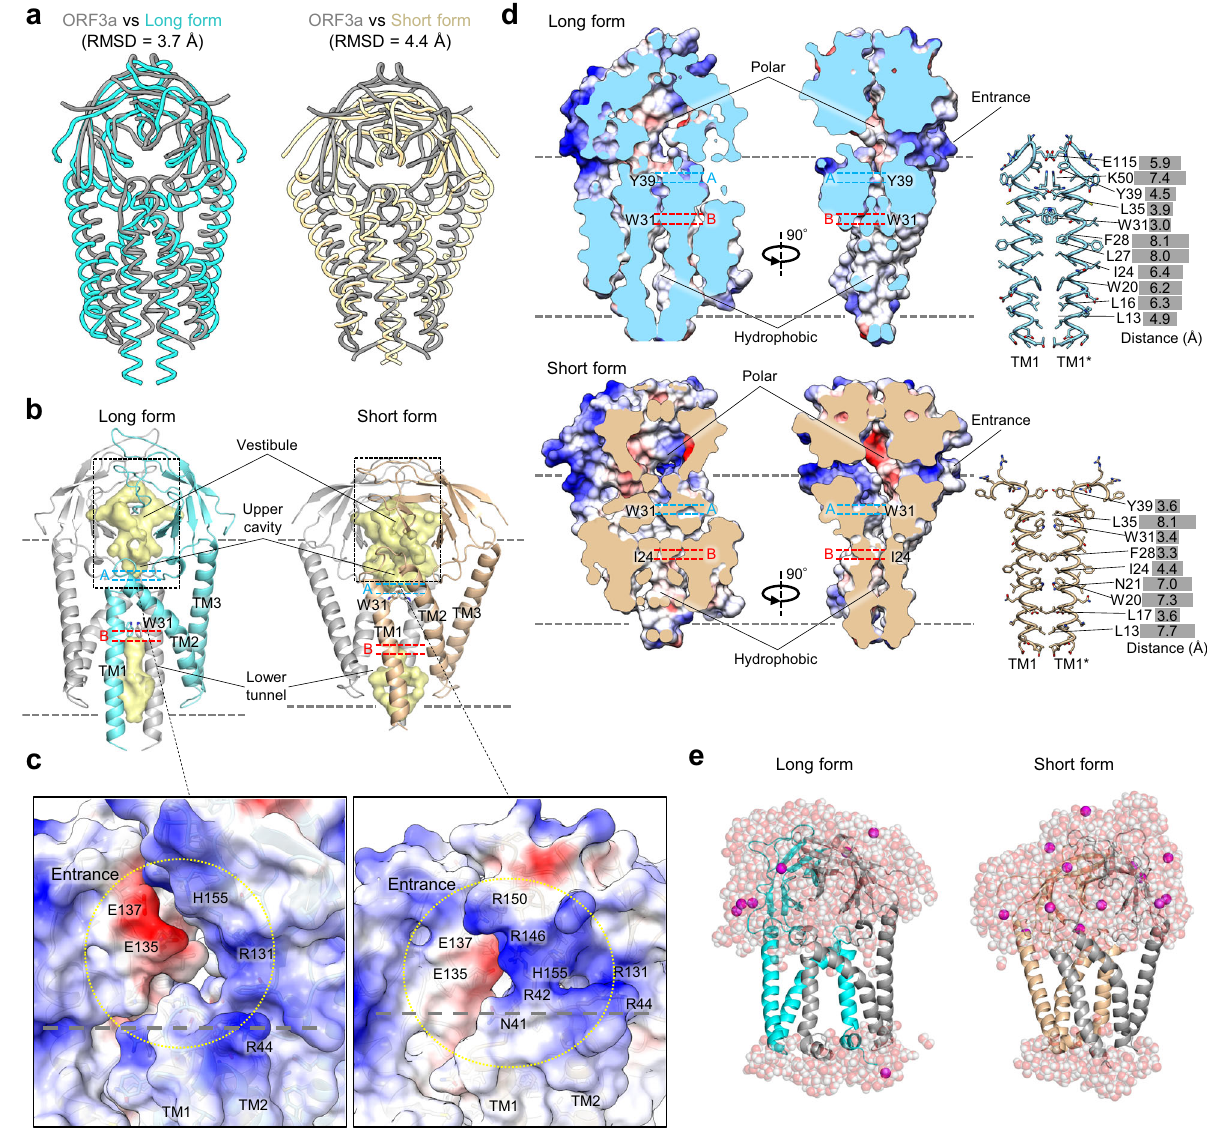
Fig. 3 | The M protein resembles the ion channel ORF3a. a Structural compar- isons of the long form (cyan) and the short form (beige) of SARS-CoV-2 M protein dimer with SARS-CoV-2 ORF3a (gray) (PDB: 6XDC). b The inner surface of the M protein dimers (vestibule, upper cavity, and lower tunnel) calculated using Pymol are shown in yellow. The bottom of the upper cavities and the top of the lower tunnelareindicated as a , b , respectively. The W31 side chain isshown using a stick representation. c Close-upviewsoftheentrancestothevestibulesabovetheupper